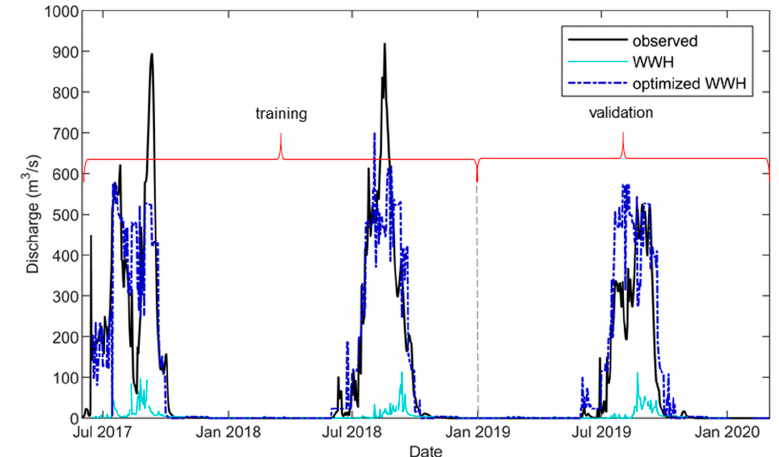
Figure 6. Hydrograph of original and optimized 5-day World-Wide HYPE forecasts in Garbey Kourou for training years (2017–2018) and validation year (2019).